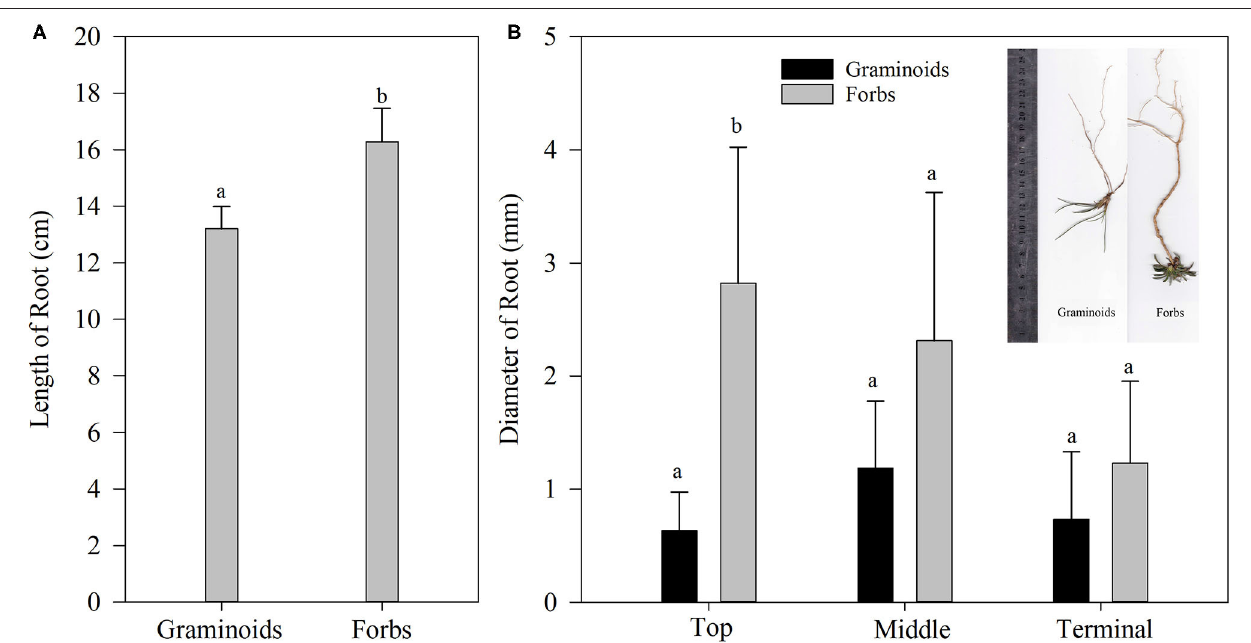
FIGURE 5 | The root morphological traits of graminoids and forbs. (A) Length of root; (B) diameter of root. Top, middle, and terminal represent the top, middle, and terminal parts (one third) of root. Different letters indicate significant difference at 0.05 level. The photo visually displays the differences of root length and thickness between graminoids and